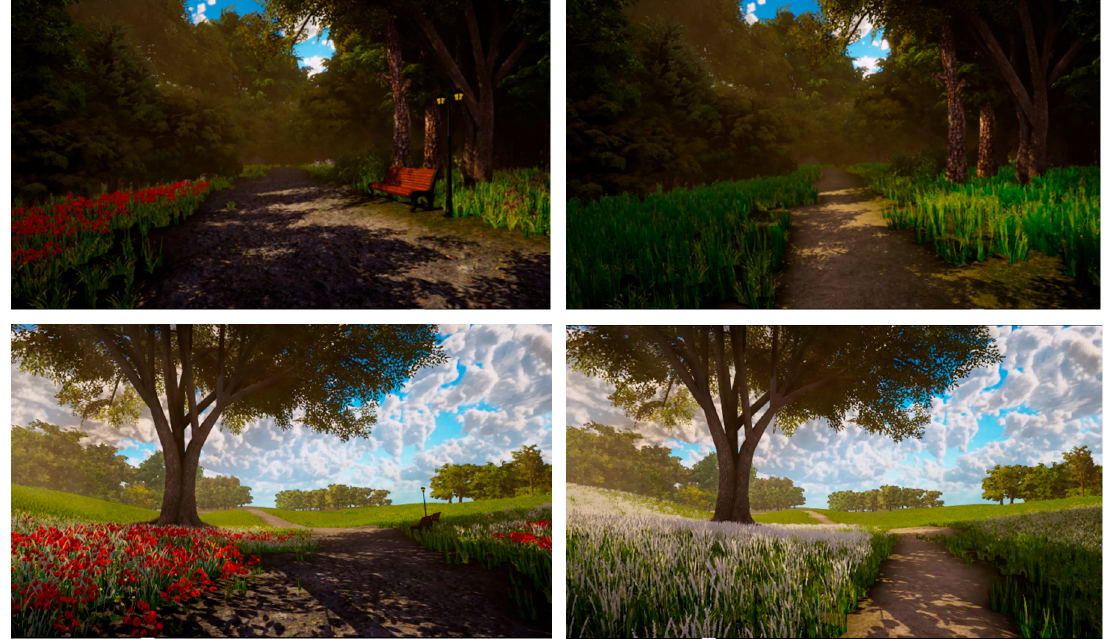
Figure 1. Screenshots of digital nature videos. From top left to bottom right: dense-tended nature, dense-wild nature, spacious tended nature, spacious wild nature.